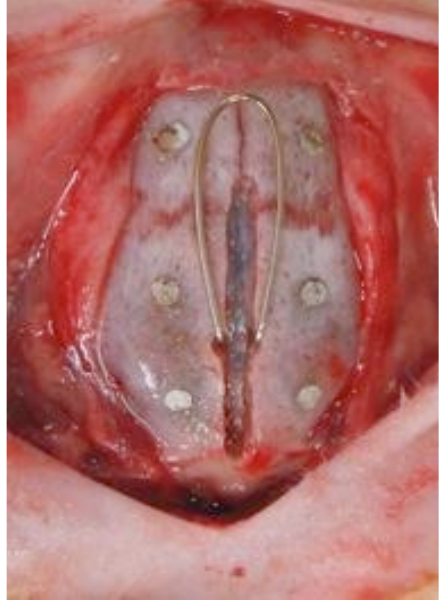
FIGURE 2 - Group III with amalgam markers, suturectomy and implantation of spring between M2 and M3